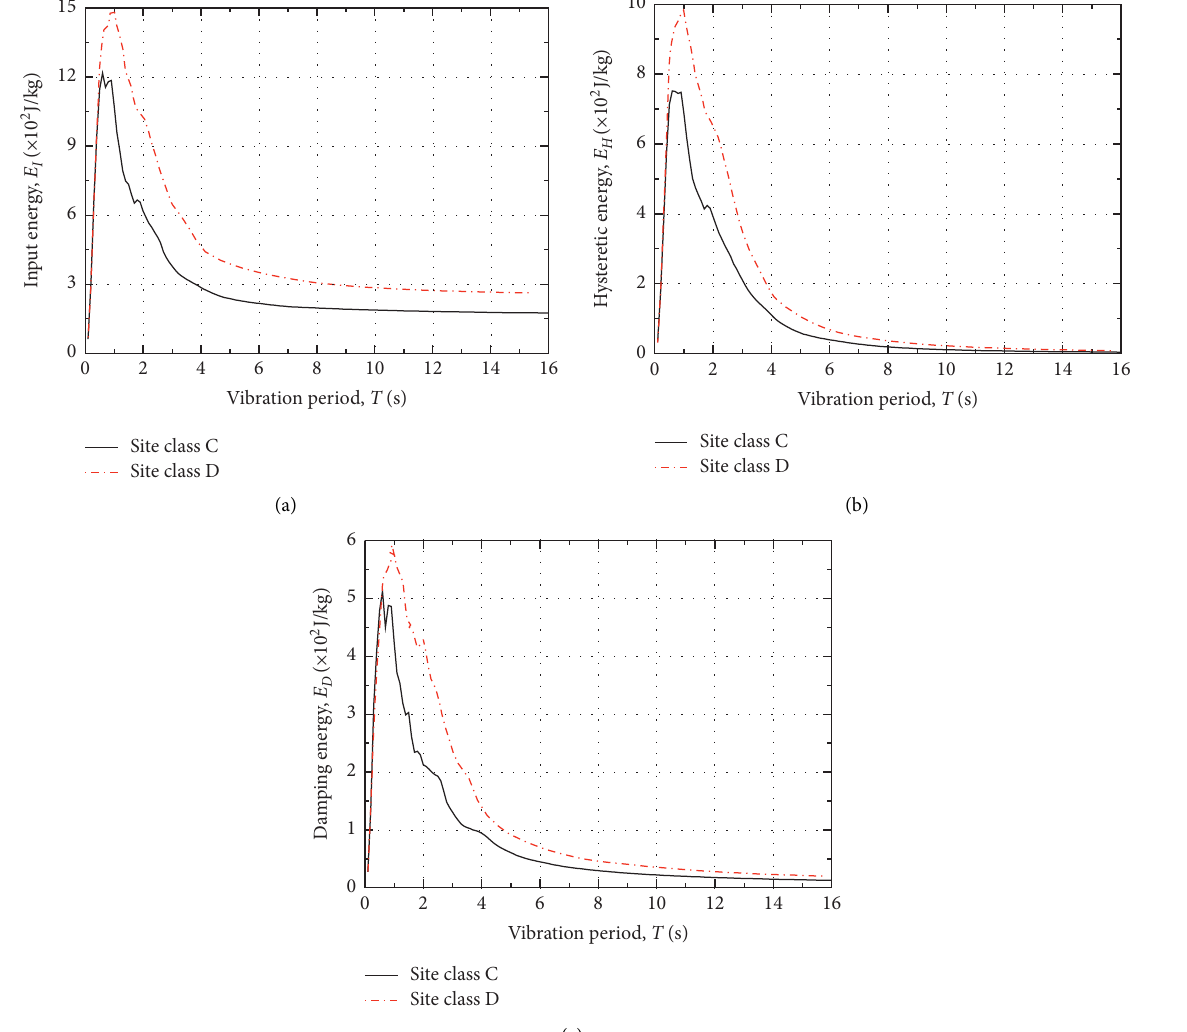
Figure 7: Energy response spectra affected by site class under near-fault pulse-like ground motions. (a) Input energy. (b) Hysteretic energy. (c) Damping